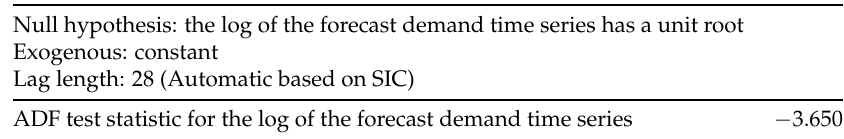
Table 5. ADF test for the log of the forecast demand time series.